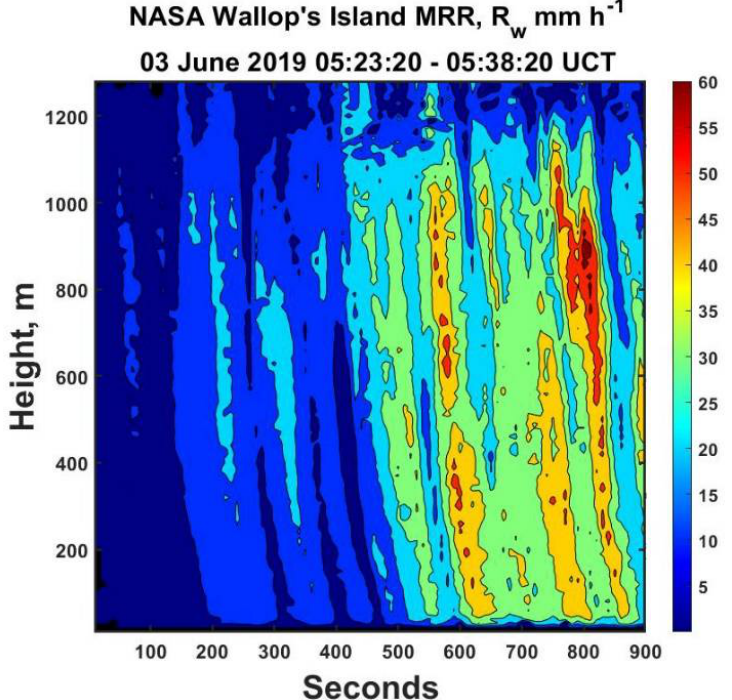
Figure 7. The time–height plot of air velocity corrected rainfall rate ( R w ) corresponding to Figure 6. Note the dramatic vertical shafts of rain that are now apparent as well as the disappearance of the spurious values at the top compared to the previous figure. Note also the general significant increase in the values of R .